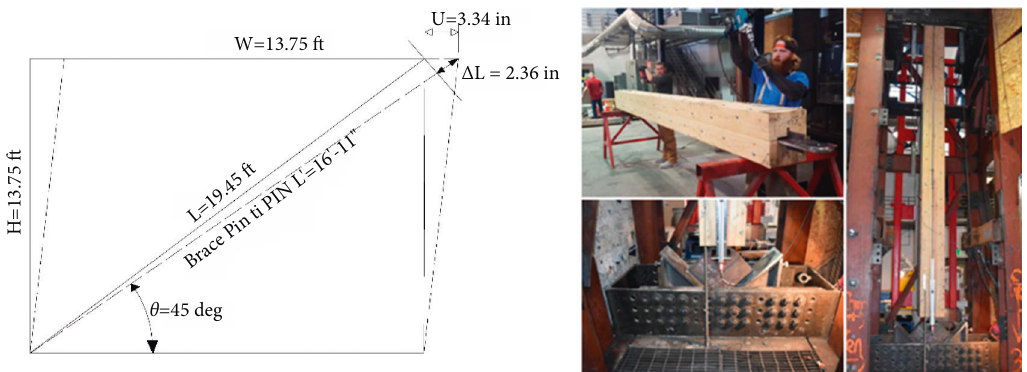
Figure 11: Tested timber-steel buckling restrained brace for verification [6].